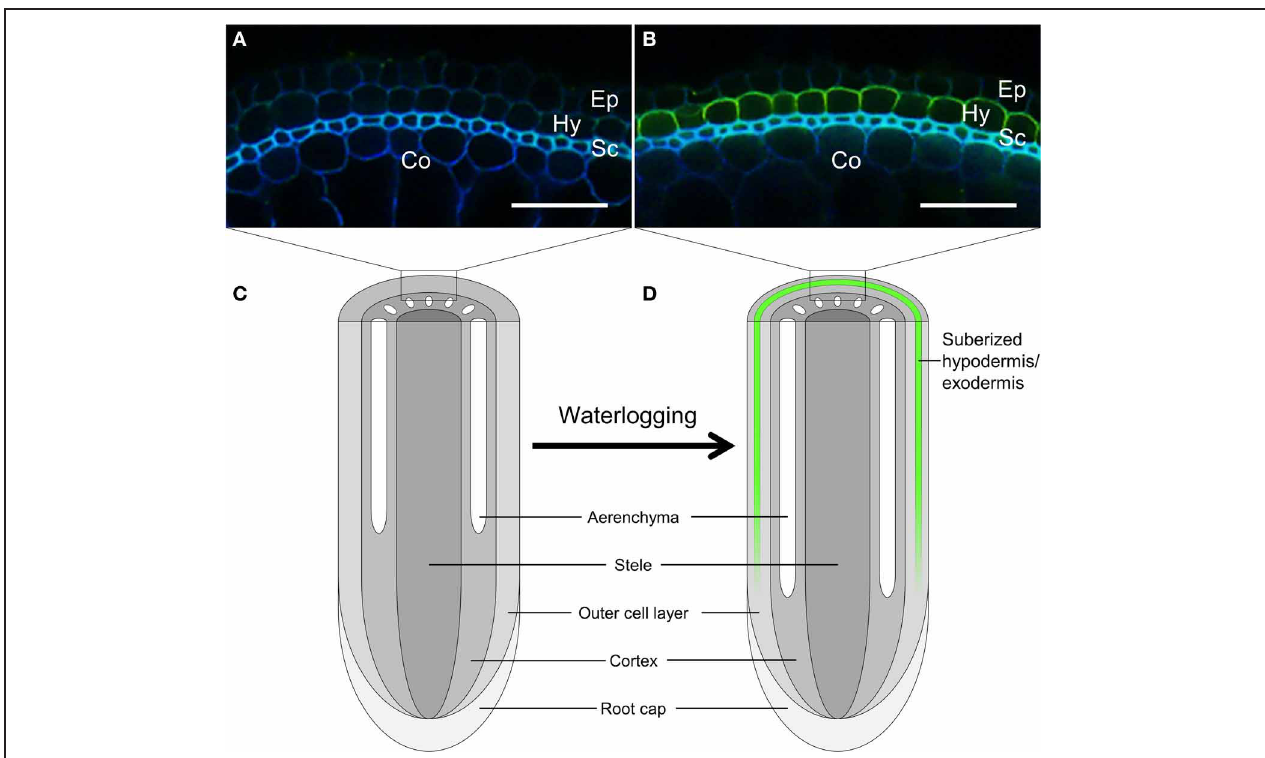
yellow green, especially in the hypodermis/exodermis, with Fluorol Yellow 088 at room temperature for 1h. The section also showed autofluorescence in blue. Ep, epidermis; Hy, hypodermis/exodermis; Sc, sclerenchyma; Co, cortex. Scale bars = 50 μ m. (C,D) Schematic diagram of longitudinal view of rice root under aerobic conditions (C) or under stagnant deoxygenated conditions (D) . Suberized hypodermis/exodermis is shown by green line at (D)